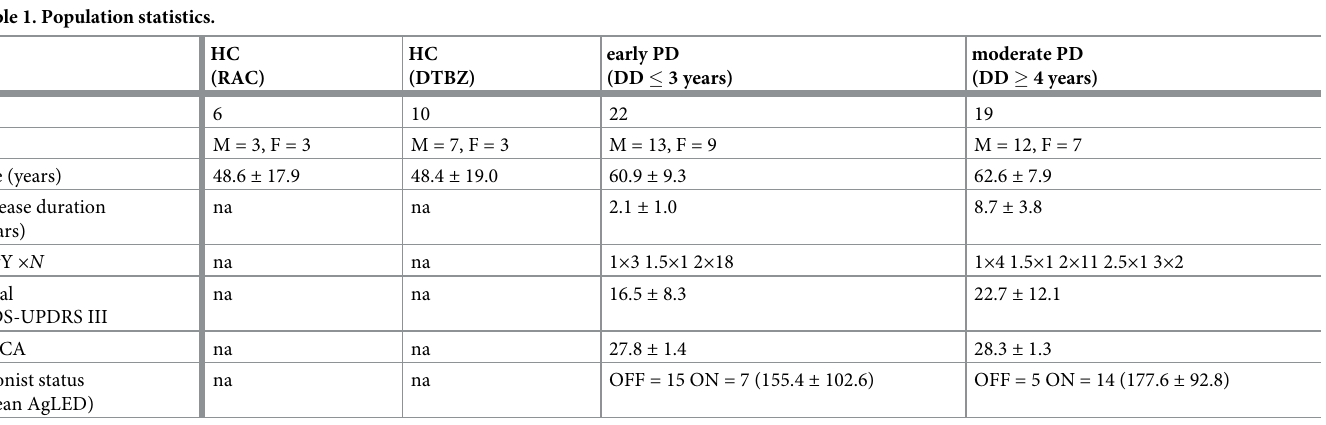
Table 1. Population